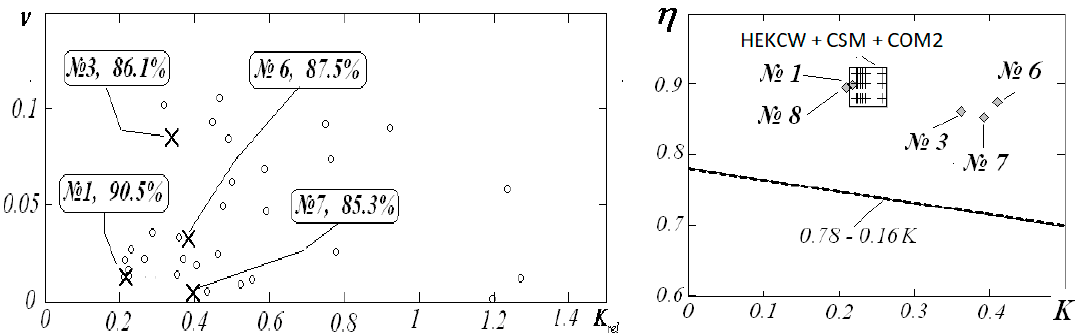
Figure 10. COM and CSM klystrons in K- ν (right) and K- η diagrams.